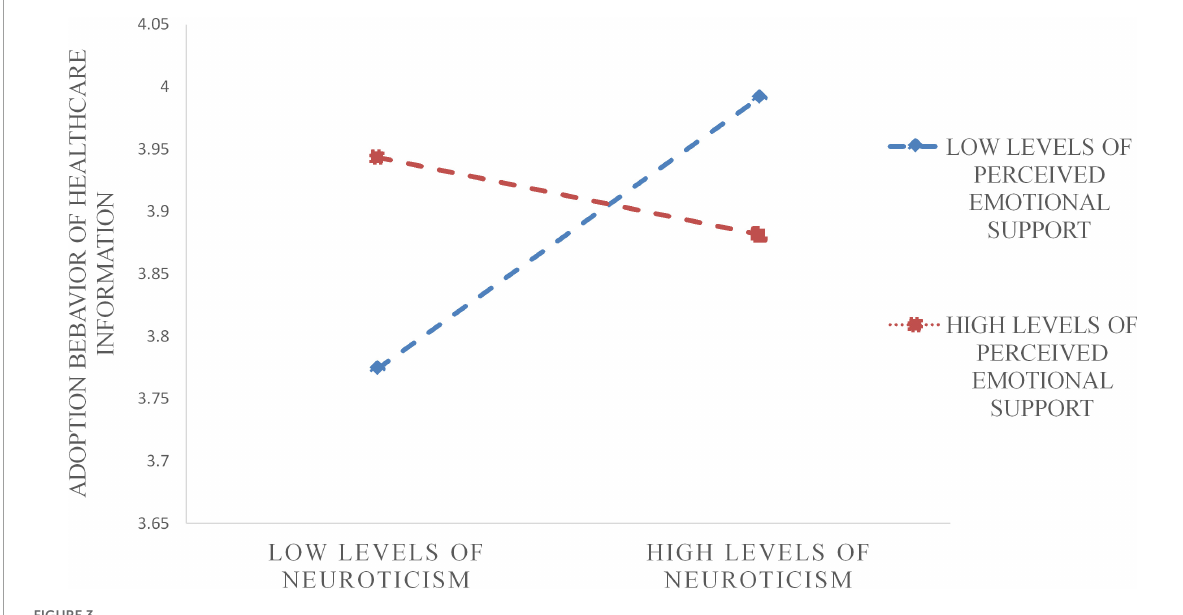
FIGURE3 Moderating effect of PES in the relationship between NP and AB.